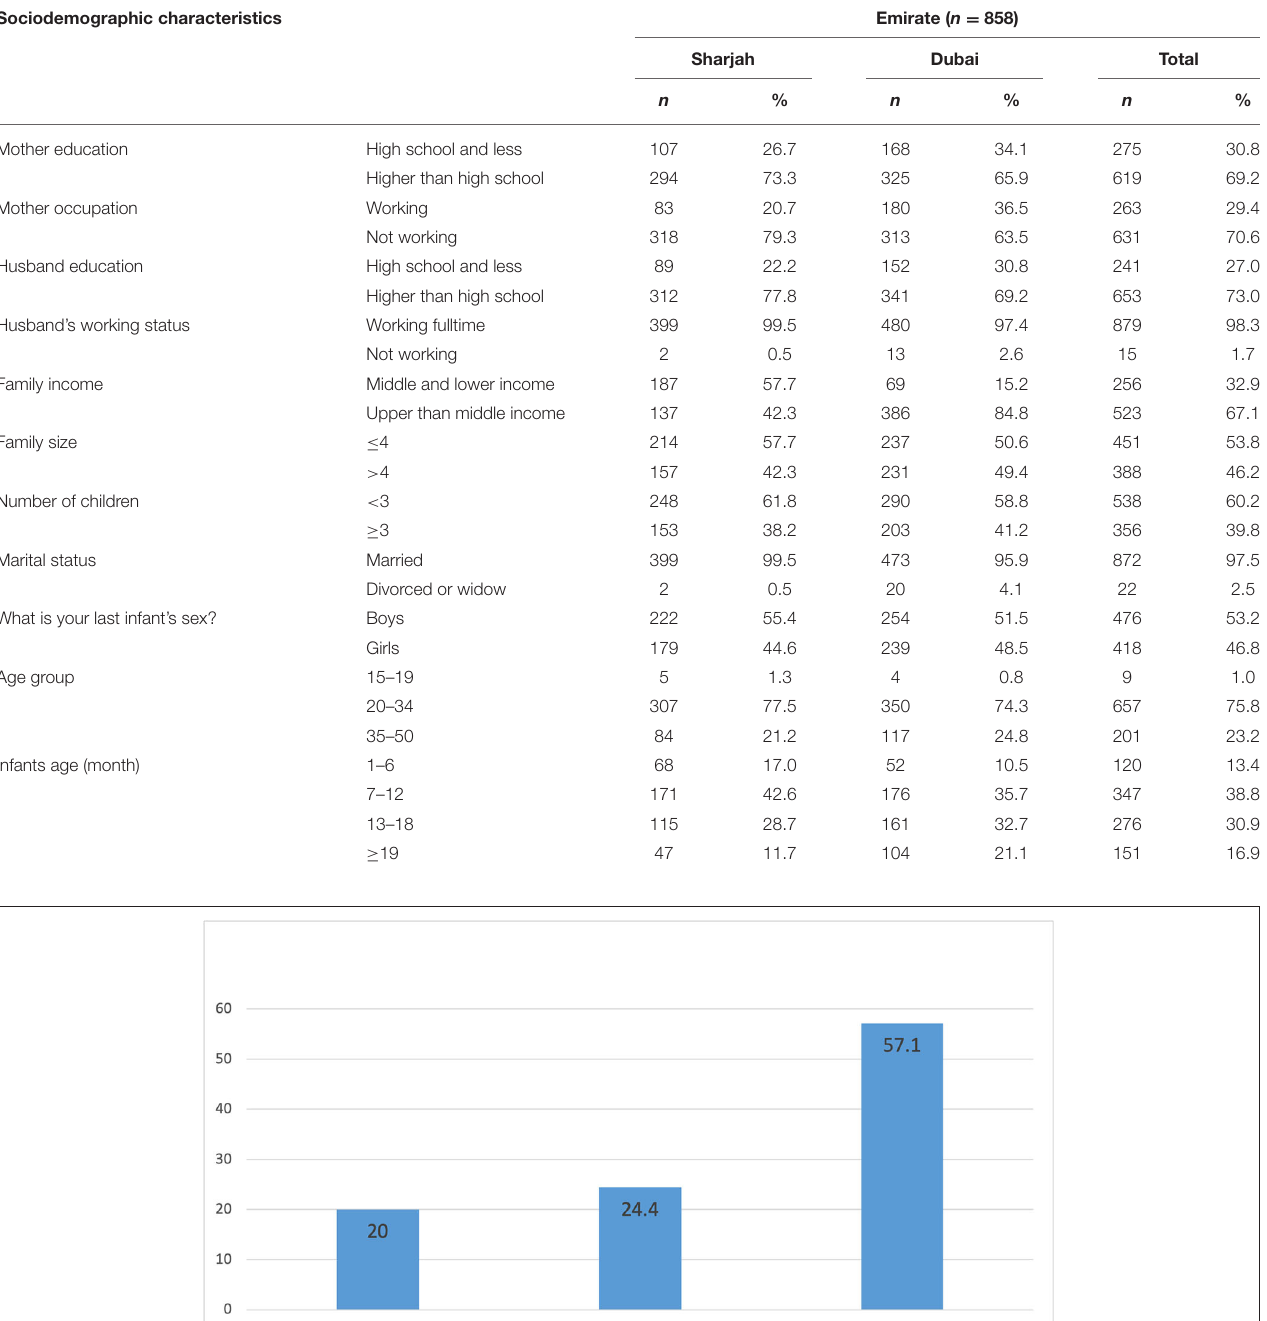
TABLE 1 | Sociodemographic characteristics of participating women in both Dubai and Sharjah. Sociodemographic characteristics